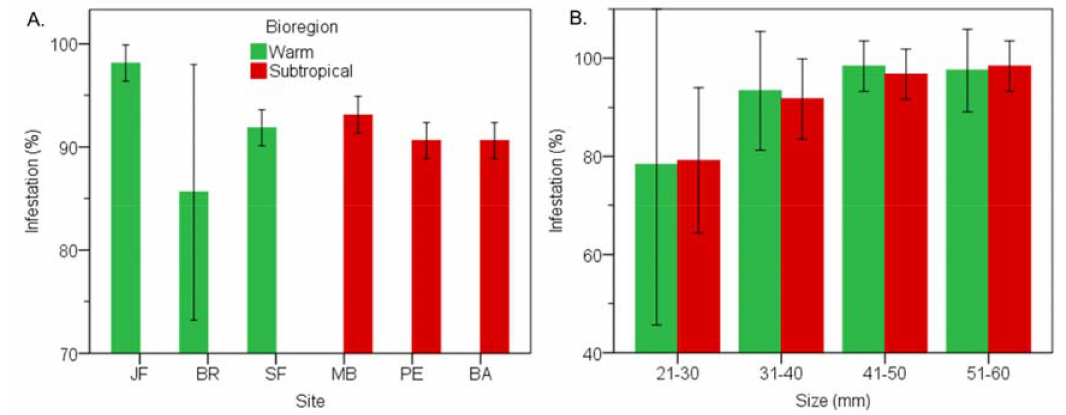
Figure 4. Overall prevalence of infestation (%; ± 95% CI) for Perna perna along the subtropical and warm temperate bioregions. Data grouped by ( A ) site with size classes pooled and ( B ) by size class with sites